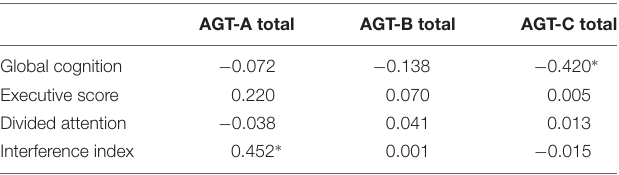
TABLE 2 | Bivariate Pearson ( r ) correlation coefficients between the AGT and neuropsychological outcomes. AGT-A total AGT-B total